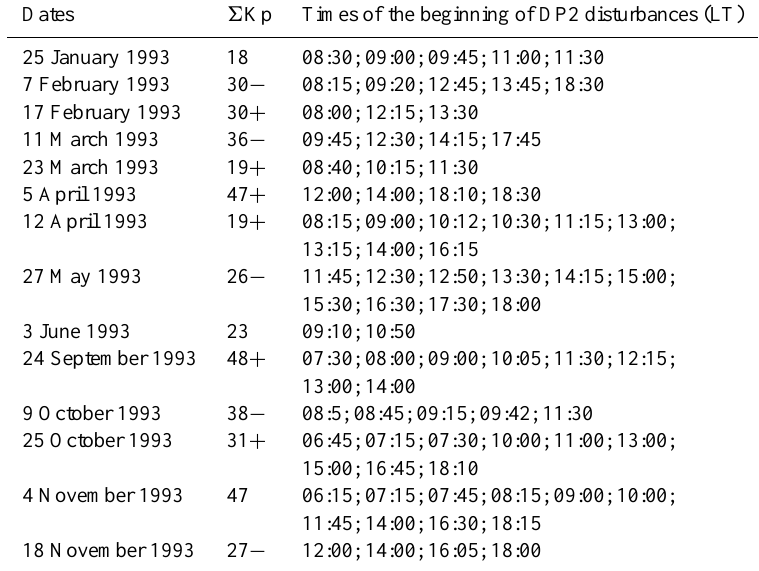
Table 2. Magnetic storms days selected in 1993 and times of the beginning of DP2 disturbances at Niell´e (NIE) over African sector. Dates 6 Kp